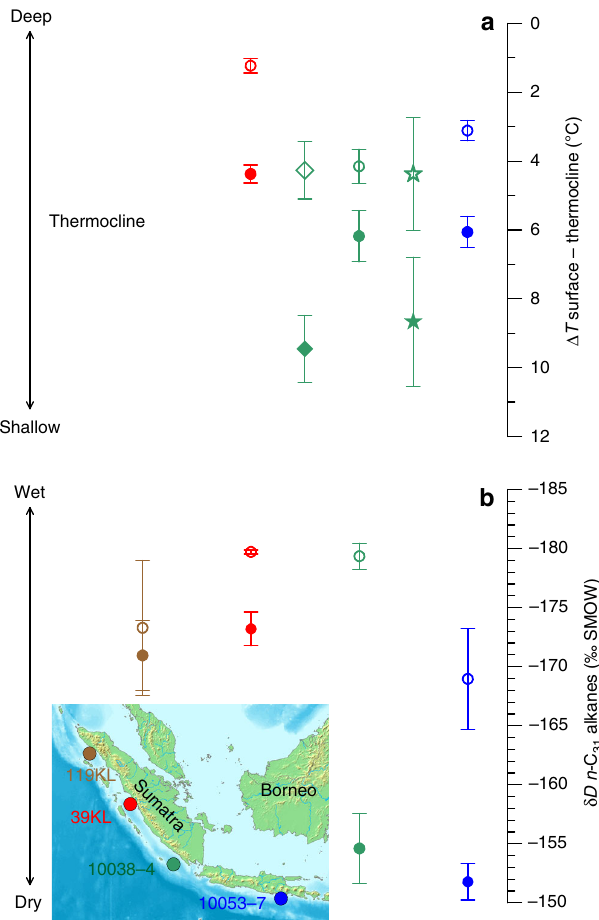
Fig. 1 Depth of the thermocline and amount of rainfall in the eastern tropical Indian Ocean during the LGM and the late Holocene. a Average values of the difference between sea surface and thermocline temperatures ( Δ T ) as a measure of thermocline depth (reverse scale) at three sites. Coloured symbols represent the average values for the late Holocene ( fi lled ) and the LGM ( open ), and correspond to the sites indicated in the inset map. Circles represent the difference between G. ruber and P. obliquiloculata , stars and diamonds between G. ruber and N. dutertrei and G. tumida , respectively. Vertical bars indicate 95% con fi dence intervals based on t -distributed samples in each time interval (Methods and Supplementary Data 1). The chronology of each period is established independently by 14 C accelerator mass spectrometry dating, each average value comprises a minimum of six samples (Methods, Supplementary Data 1). b As in a but for the average δ D values from plant waxes ( n -C 31 -alkanes) by including an additional record (SO189-119KL). LGM values are corrected for relative changes in